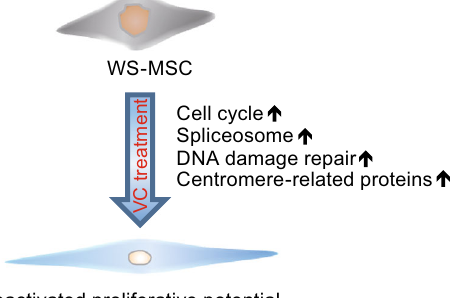
Figure 5. A proposed model illustrating that VC represses aging properties in WS MSCs by causing a global transcrip- tome change of aging-suppressing genes and